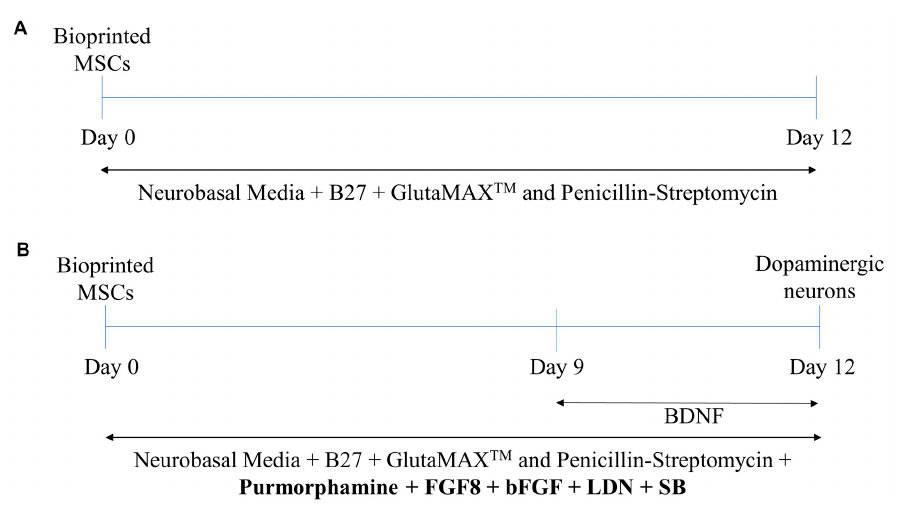
Figure 2 Figure 2. Schematic of cell culture period for ( A ) control group and ( B ) experimental